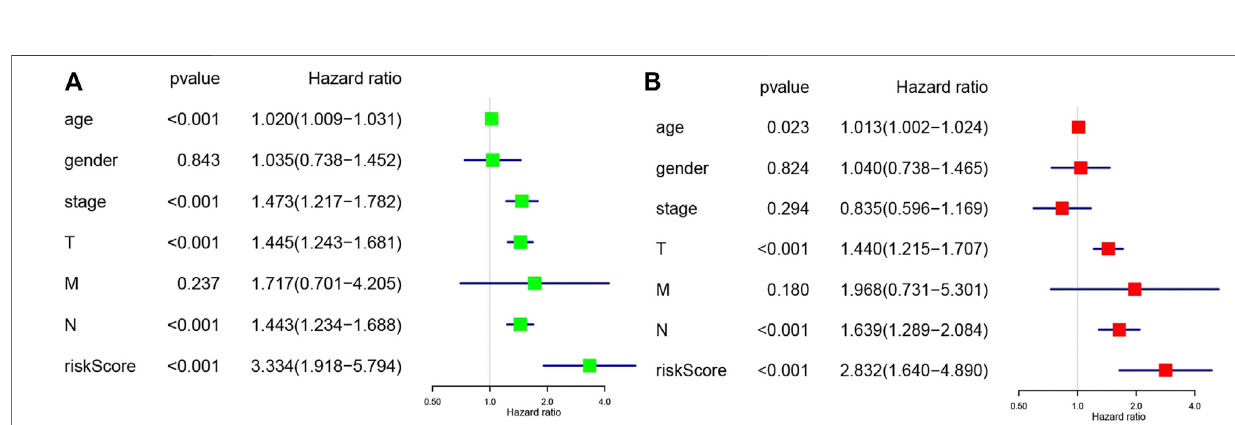
Frontiers in Molecular Biosciences |